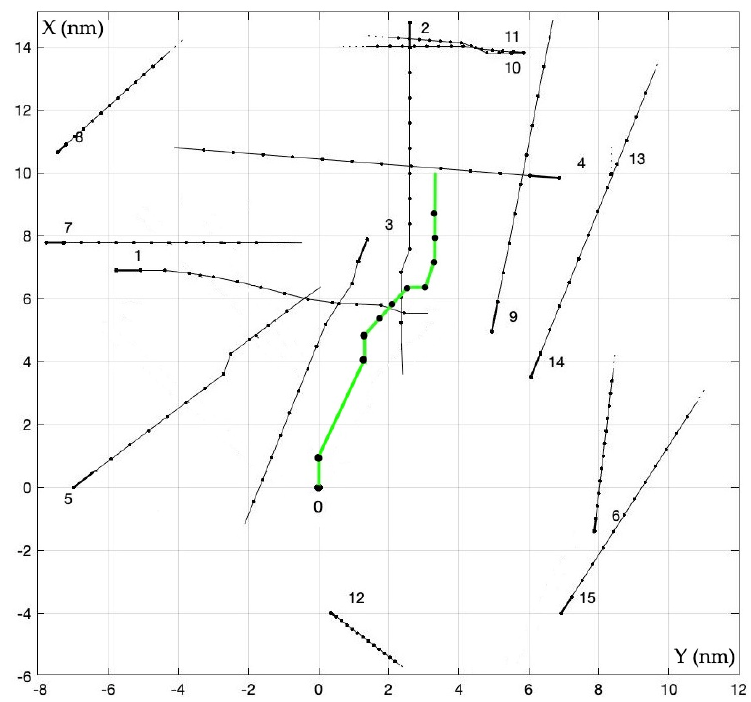
Figure 9. Trajectories of ships in cooperative positional game ANCPGC.